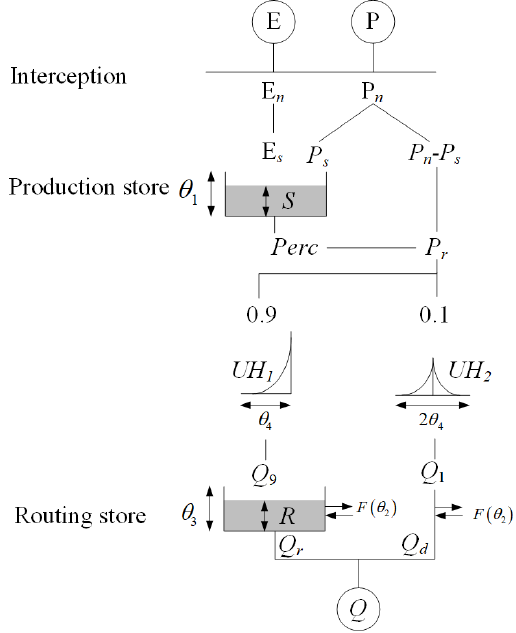
Figure 2. Schematic diagram of the GR4J rainfall–runoff model adopted by Perrin et al. (2003). In the figure, P and E refer to pre- cipitation and evapotranspiration, respectively; E n and P n denote net precipitation and net evapotranspiration, respectively; P s refers to the part of precipitation that fills the production store (i.e., S ). The production store is determined as a function of the water level S in the production store. θ 1 , θ 2 , θ 3 , and θ 4 denote model parameters. The Perc refers to the percolation leakage that is a function of pro- duction store S and parameter θ 1 . The P r refers to the total quantity of water that reaches the routing functions. UH1 and UH2 denote two-unit hydrographs. Q 1 and Q 9 refer the corresponding output of the unit hydrographs, respectively; F indicates the groundwater exchange term; R is the level in the routing store. Q r refers to the outflow of the routing store, Q d is a function of water exchange, and Q refers to the total